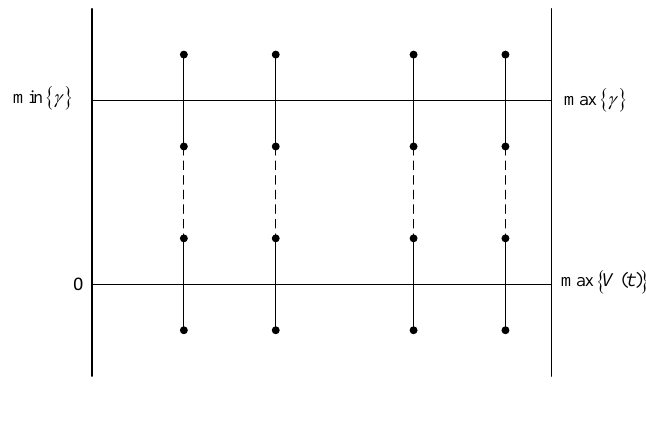
Figure 1. Spectrum quality initiative